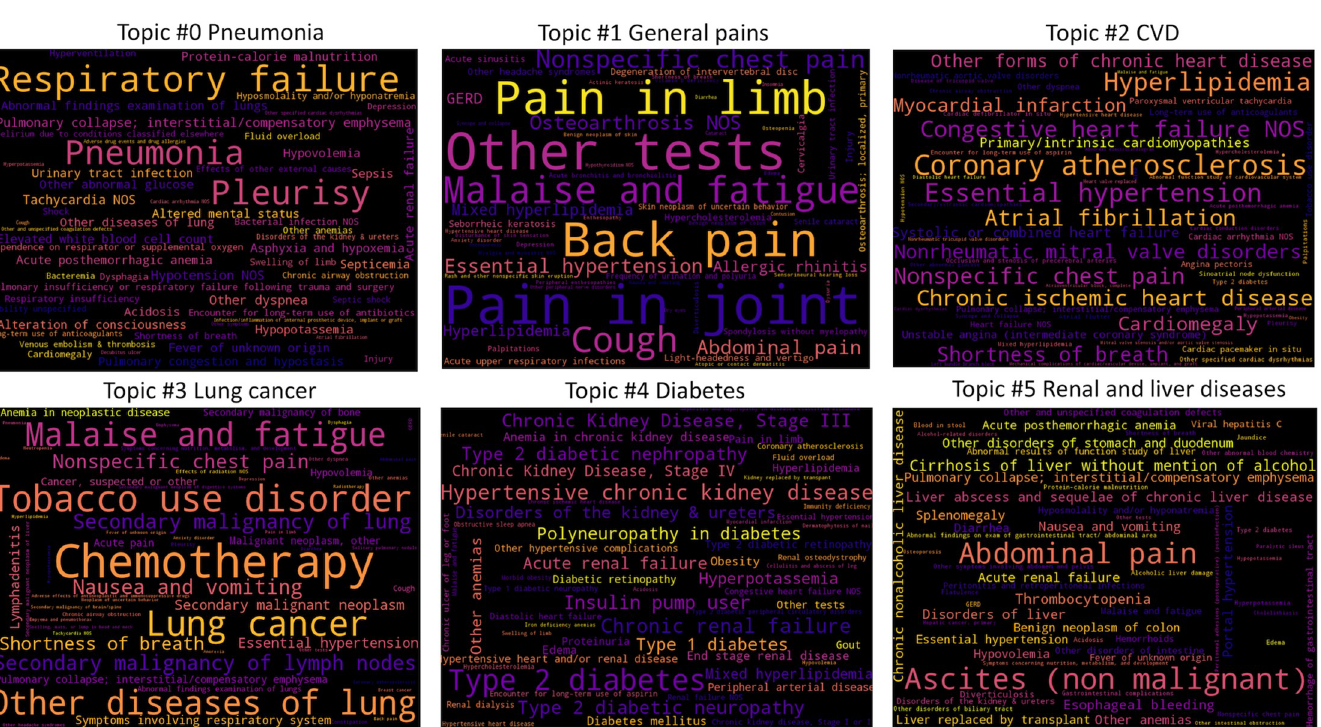
Fig 2. Word clouds for six topics. The size of the words (phecode) in each cloud indicates the weights of the phenotypes on the topic. Phenotypes with larger-sized words have greater influence on the topic compared to phenotypes with smaller-sized words. For each word cloud, we listed the top 60 words.